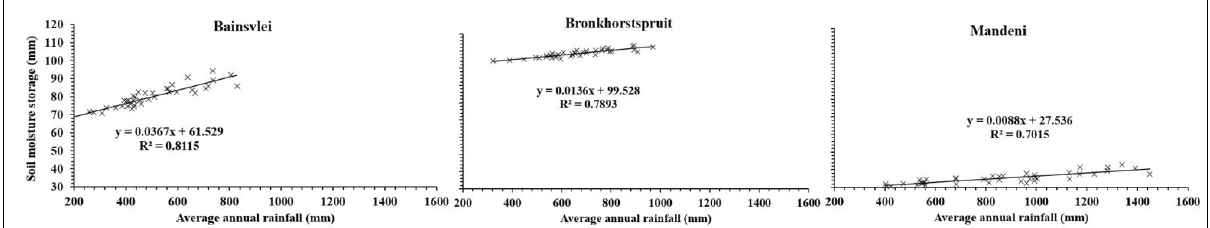
) and average annual soil moisture over 39 years at three different locations. air